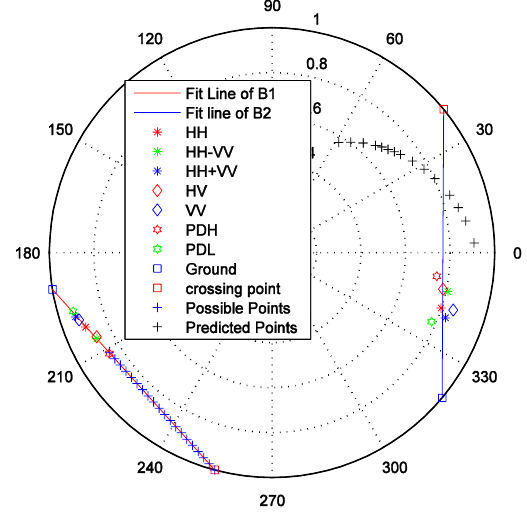
Figure 4. Dual-baseline volume-only coherence